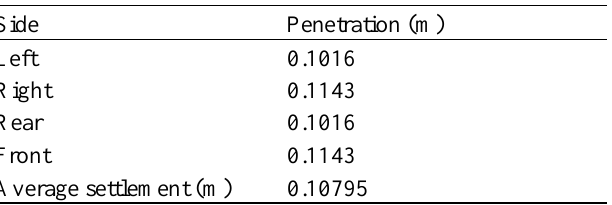
Penetration of Structure inside the Ground in Untreated